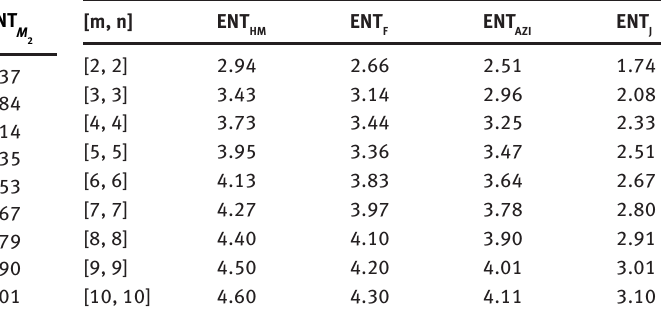
Table 5: Comparison of first Zagreb entropy and second Zagreb entropy for T 1 C